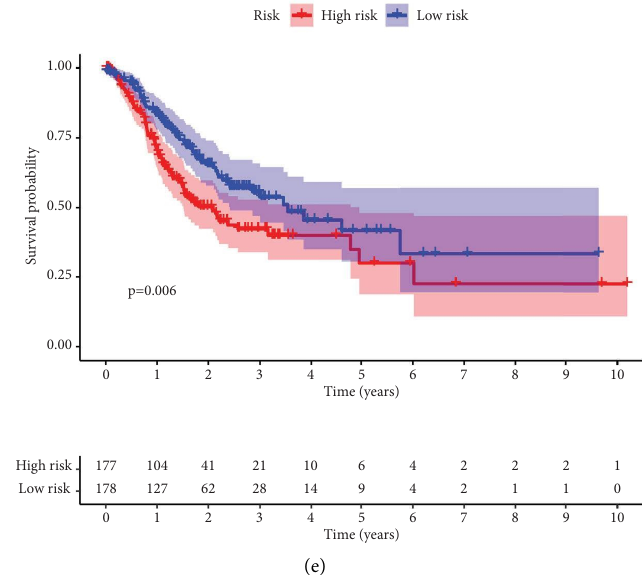
Figure 3: (a) Te results of univariate cox regression analysis; ((b)-(c)) the results of lasso regression analysis; (d) the risk plot between low- and high-risk groups; (e) the survival analysis between low- and high-risk